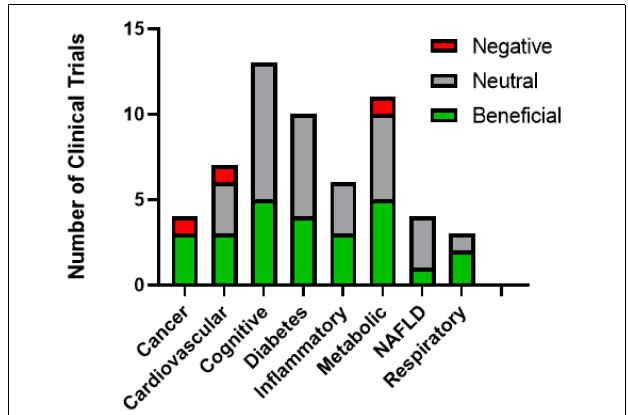
FIGURE 2 | Summary of resveratrol clinical trial